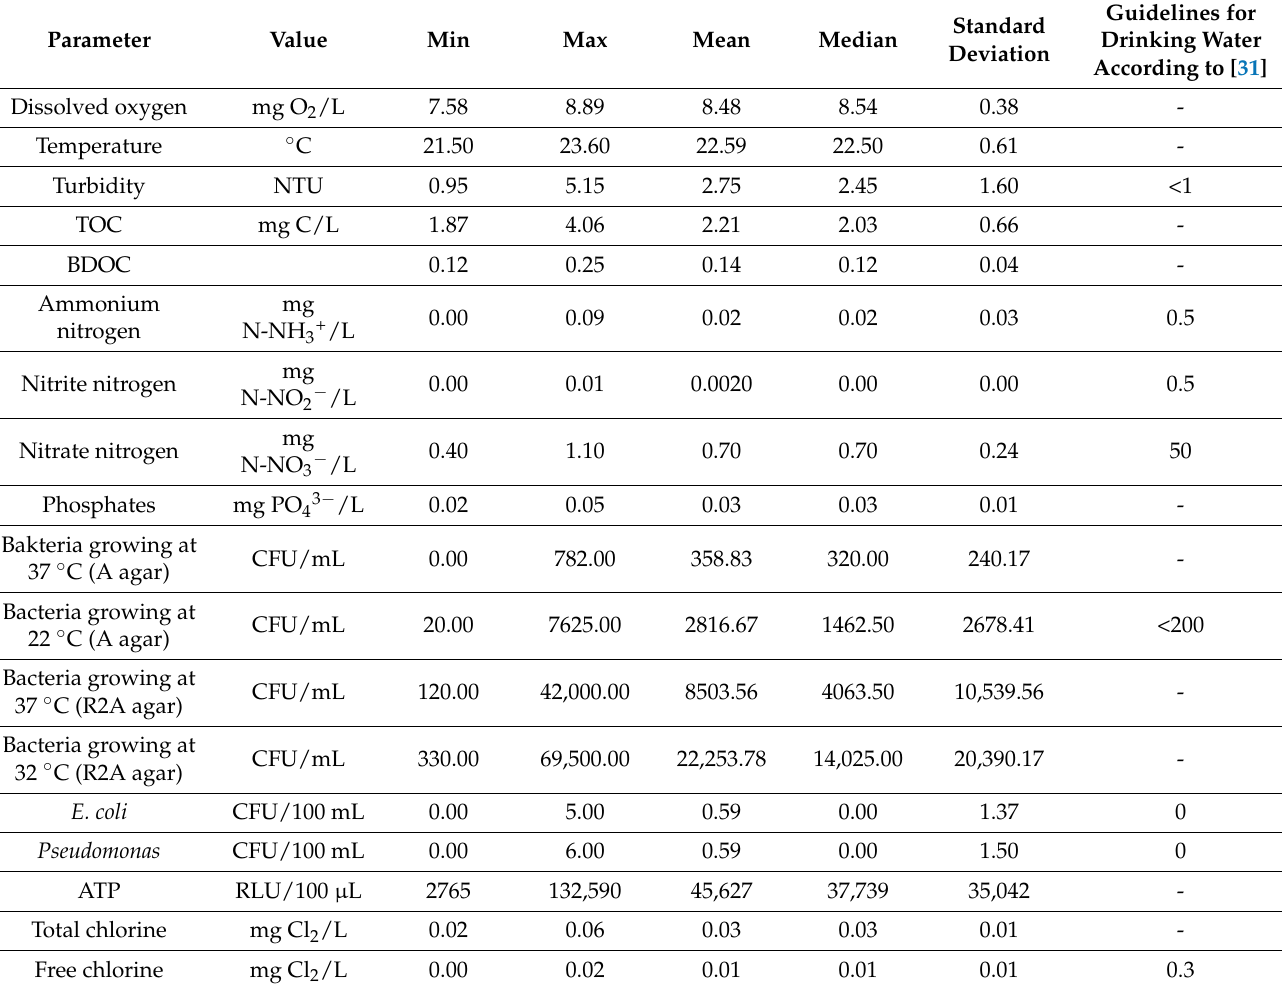
Table 5. The quality of the water flowing out of the experimental installation (n =